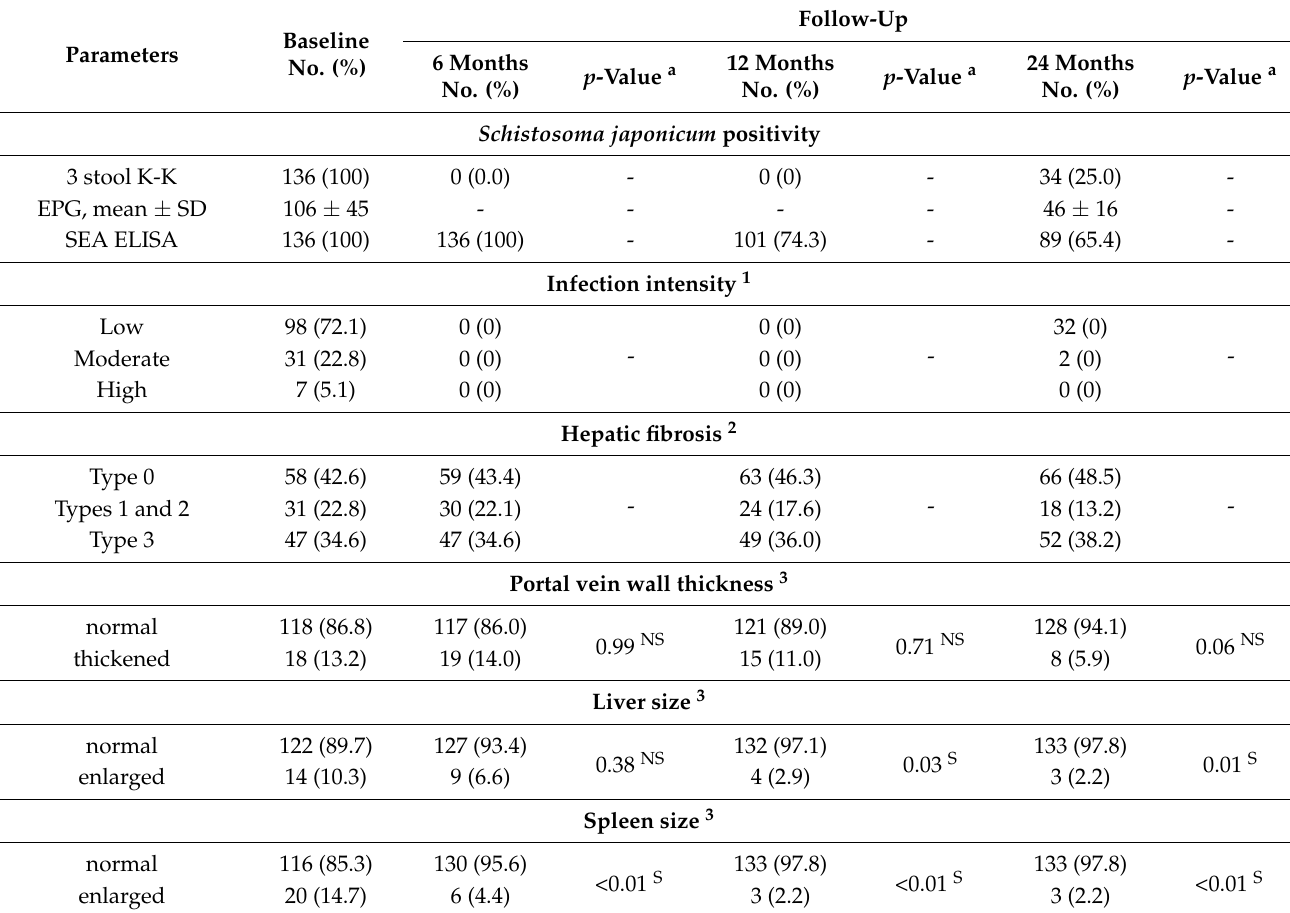
Table 2. Descriptive characteristics of the 136 patients enrolled in the prospective study at baseline and 6, 12, and 24 months after PZQ